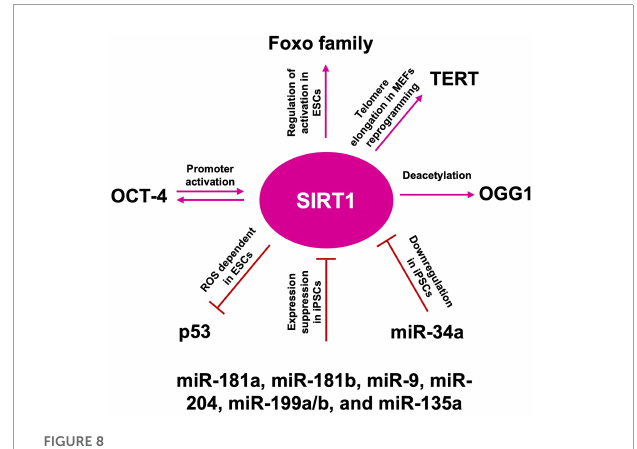
FIGURE8 SIRT1 role in telomere length maintenance and cellular reprogramming. SIRT1: acts on OGG1 deacetylation, preserving telomere repairing; activates TERT transcription promoting telomere elongation; acts by blocking p53 nuclear translocation through ROS favoring the reprogramming; mutually interacts with OCT-4 in the cellular reprogramming process; activates FOXO family of transcription factors, which are required to maintain pluripotency; miR-181a, miR-181b, miR-9, miR-204, miR-199a/b, and miR-135a suppress SIRT1 expression, facilitating iPSCs reprogramming and pluripotency; downregulated by miR-34a promotes iPSCs differentiation into